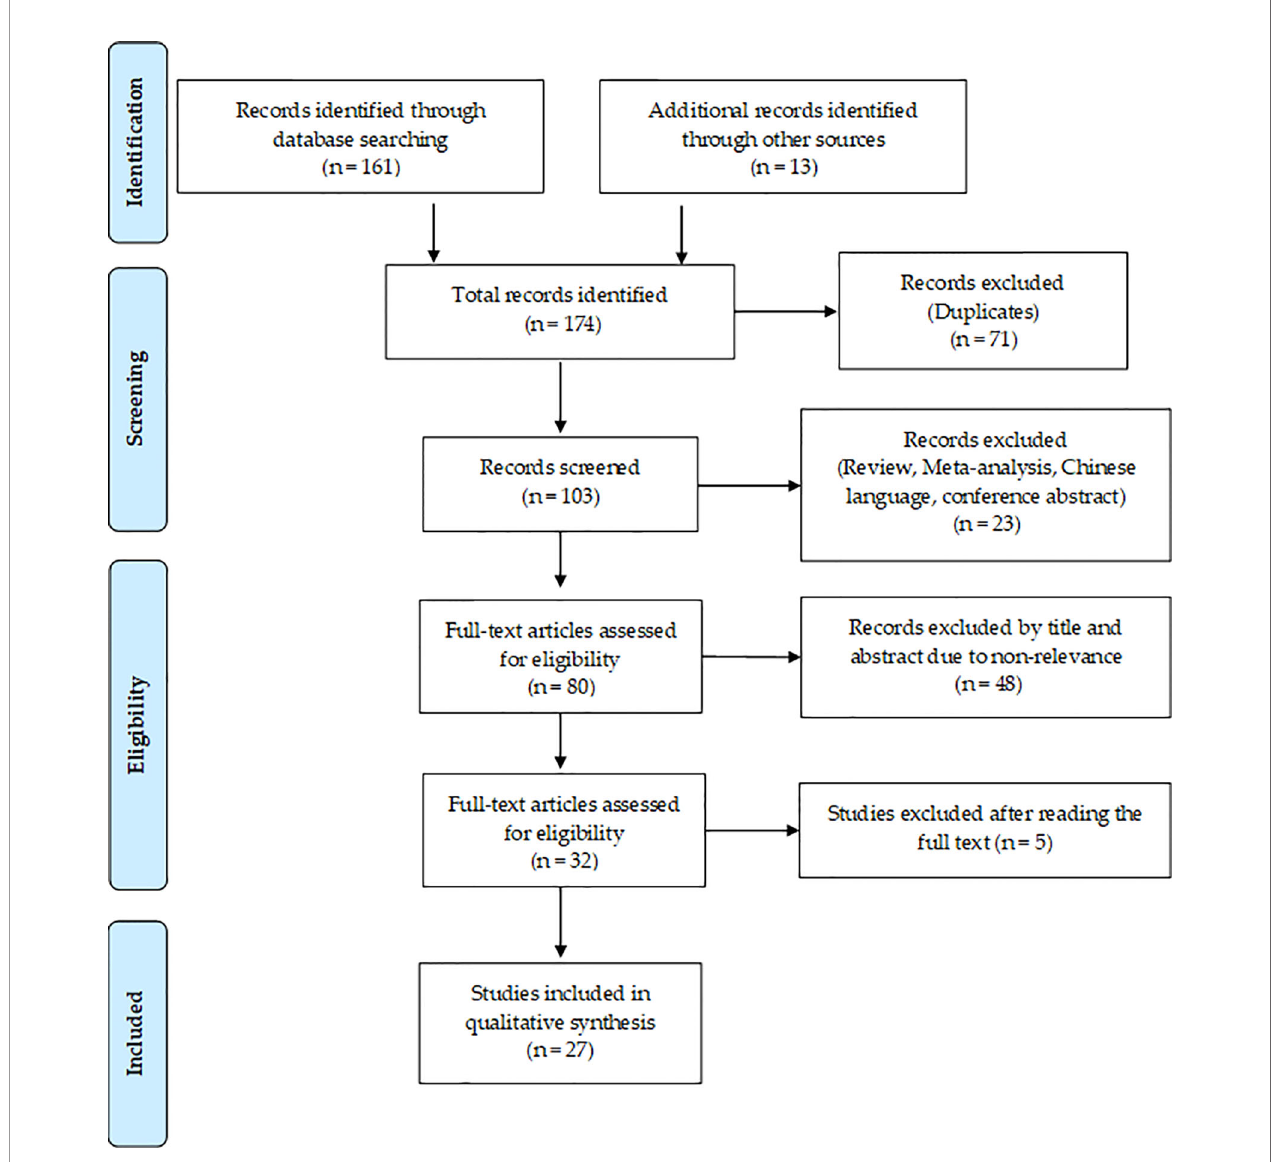
FIGURE 1 | Flowchart for the strategy searches and selection